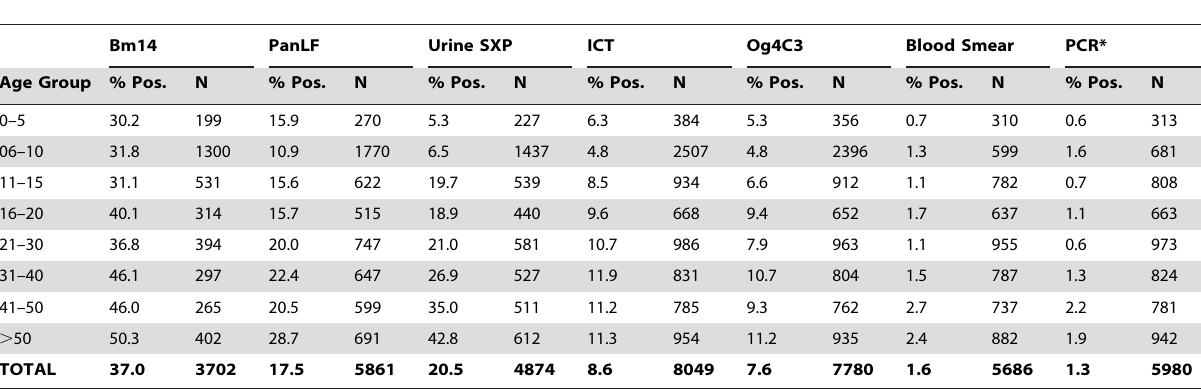
Table 8. Prevalence of positive results by age group (all